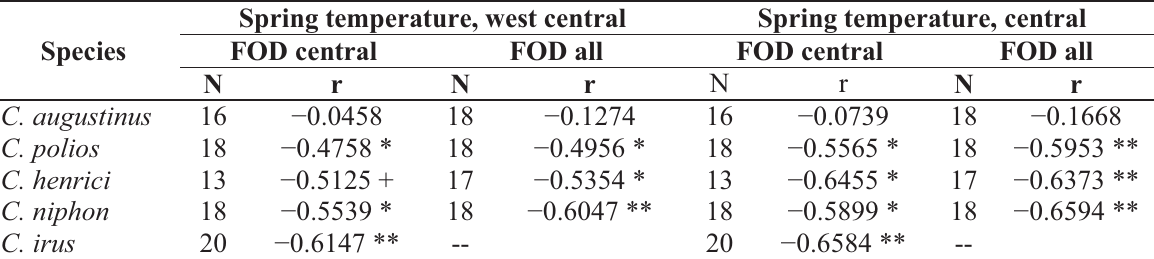
Table 8. Spearman rank correlation coefficients (r) of first observed date (FOD), calculated using either surveys only in central Wisconsin (central) or all survey data including from northern Wisconsin and northeastern Minnesota (all), with spring temperature (March- April-May) through 2011 in the west central or central Wisconsin regions. + p < 0.10, * p <0.05, ** p < 0.01.